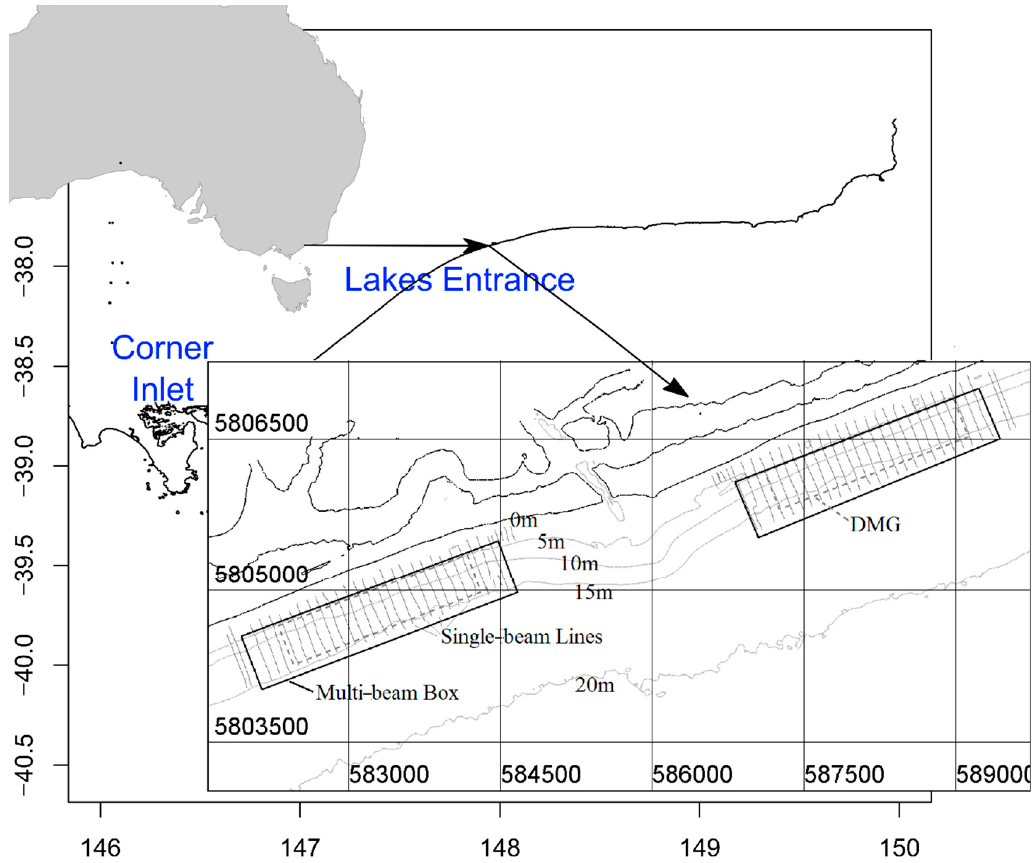
Figure 1. Map of Ninety Mile Beach in southeastern Australia (nautical coordinates) with an overlay of Australia (top right) and an insert of bathymetric surveys at Lakes Entrance (bottom right, WGS84 zone 55 coordinates). The insert of Lakes Entrance provides examples of the single-beam transects (cross-shore lines separated by 100 m) and multi-beam survey area (thick black box) at both the west and east dredge material grounds (DMG) sites (grey dashed box).